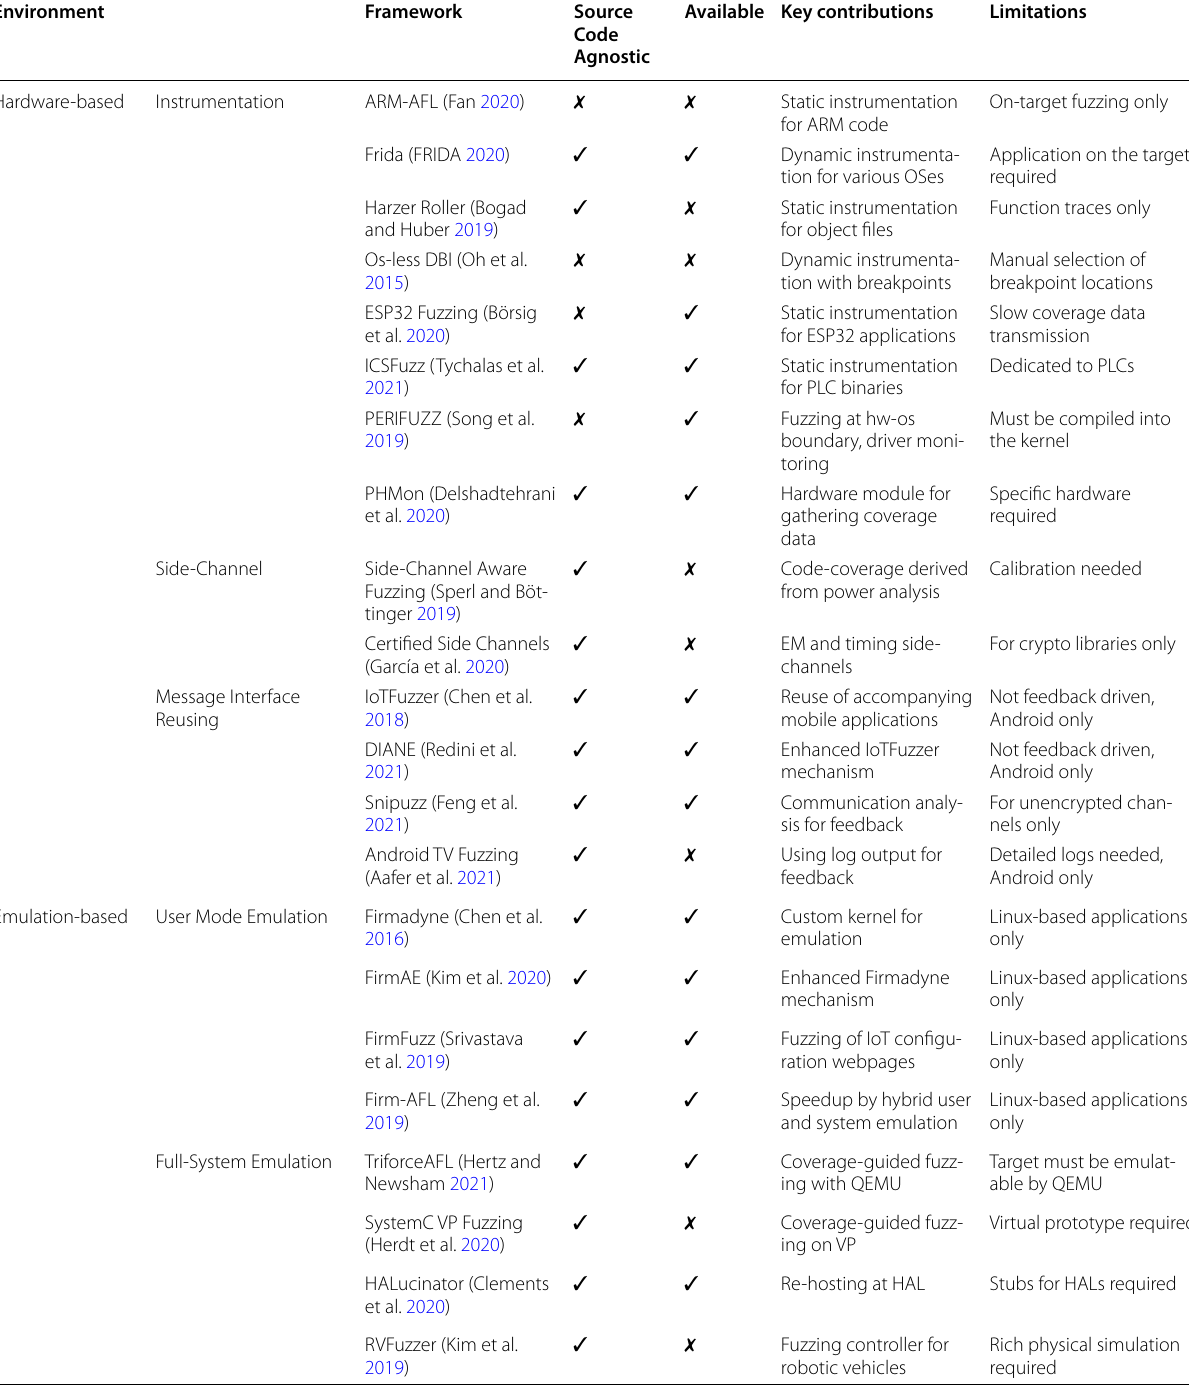
Table 2 Reviewed embedded fuzzing works